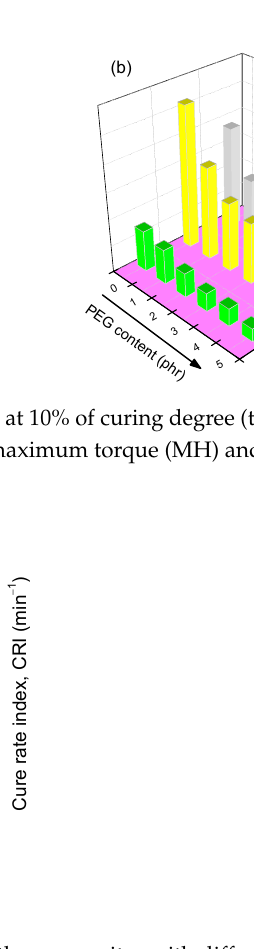
Figure 3. Vulcanization characteristics: ( a ) the time at 10% of curing degree (t10), optimum cure time (t90) and t90–t10 and ( b ) minimum torque (ML), maximum torque (MH) and MH–ML.